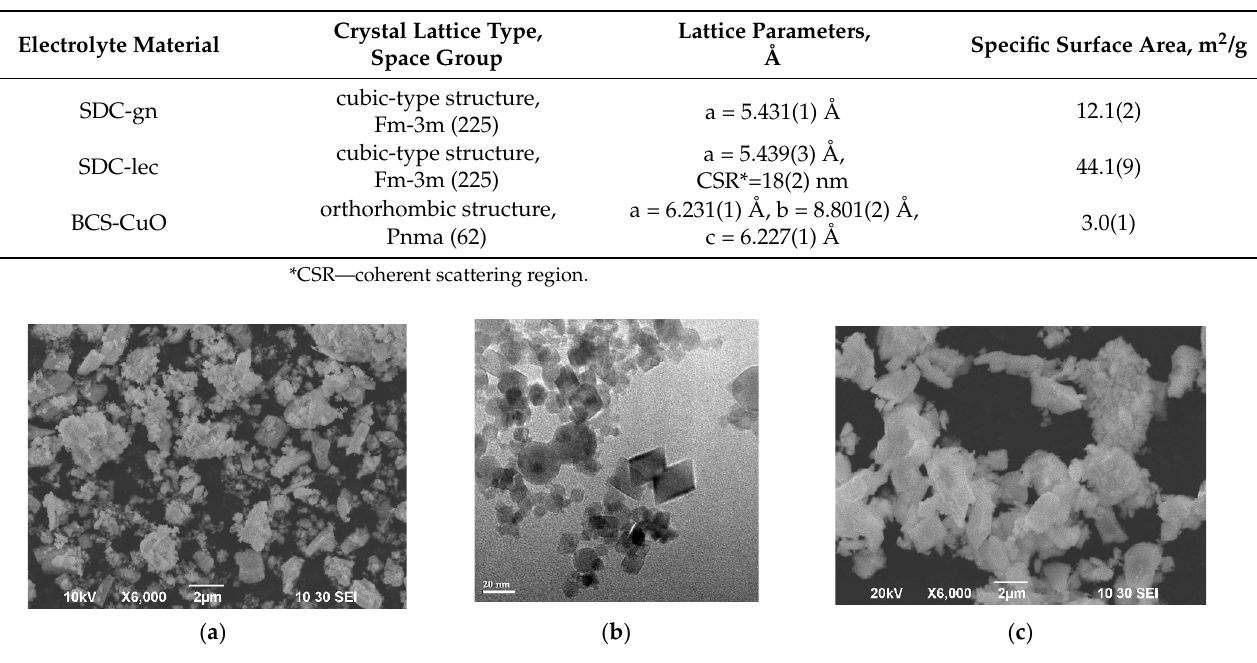
Figure 1. Morphology of the initial electrolyte powders used for the suspension preparation: ( a ) SDC-gn (T calc = 900 °C) (SEM image); ( b ) SDC-lec (TEM image); ( c ) BCS-CuO (T calc = 1150 °C) (SEM image).